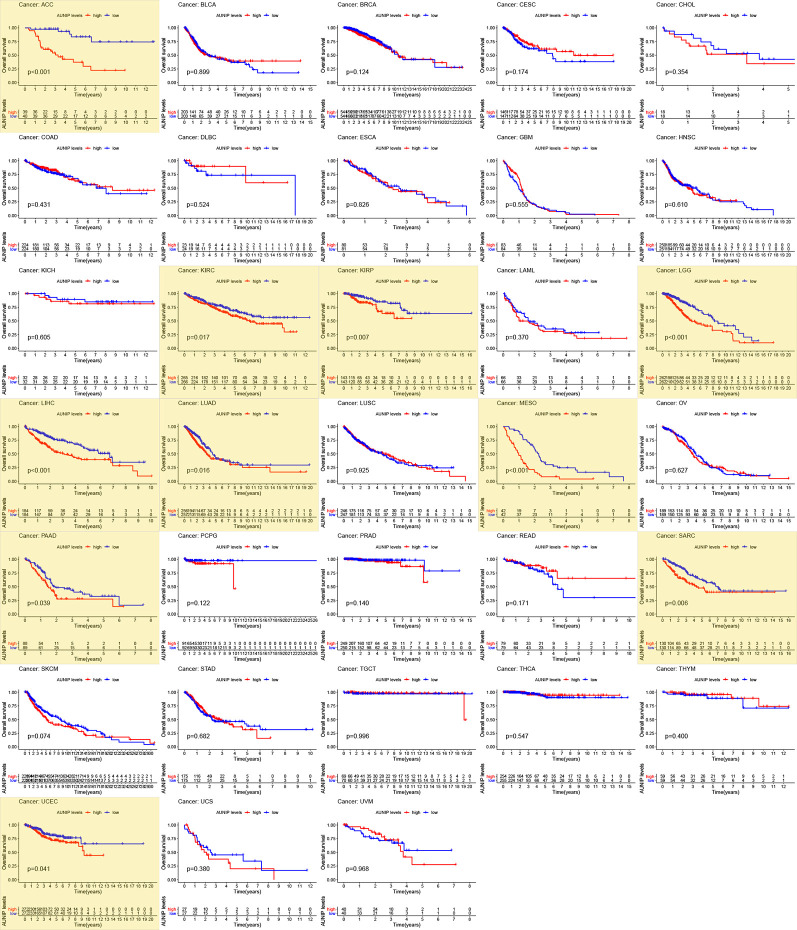
Survival analysis of 33 cancer types based on TCGA data. P < 0.05 indicates statistical significance and the significant values are marked in yellow.